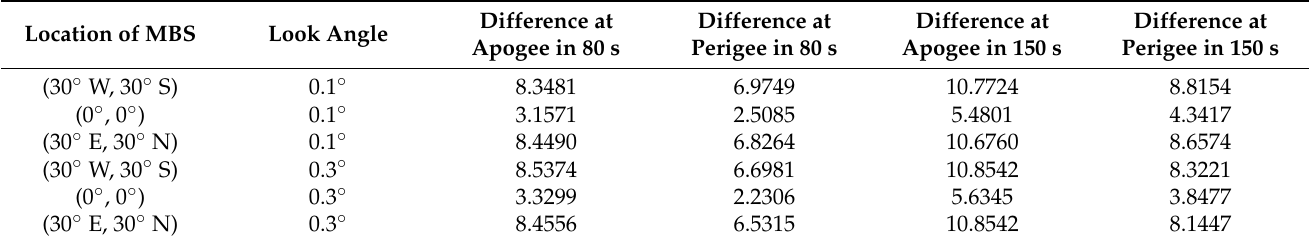
Table 2. The maximum difference in the delay range (m) (i.e., the maximum value between the down- link path and the uplink path) for various MBSs at one approximate apogee (i.e., 19:01:01 24 January 2001) and one approximate perigee (i.e., 09:01:01 10 January 2001), with the synthetic aperture time being about 80 s and 150, respectively.